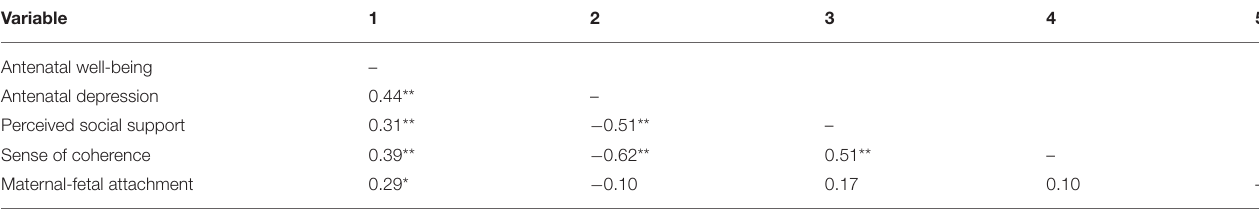
TABLE 2 | Correlation Matrix - antenatal depression, antenatal well-being, maternal-fetal attachment, perceived social support, and sense of coherence. Variable